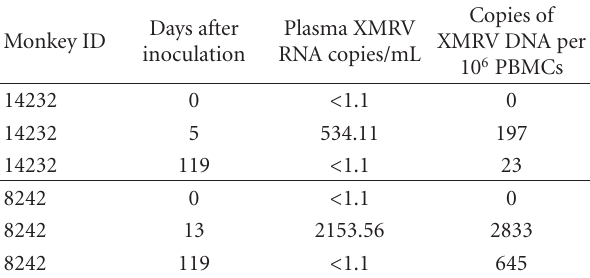
Table 1: X-SCA Results on XMRV-inoculated macaques.